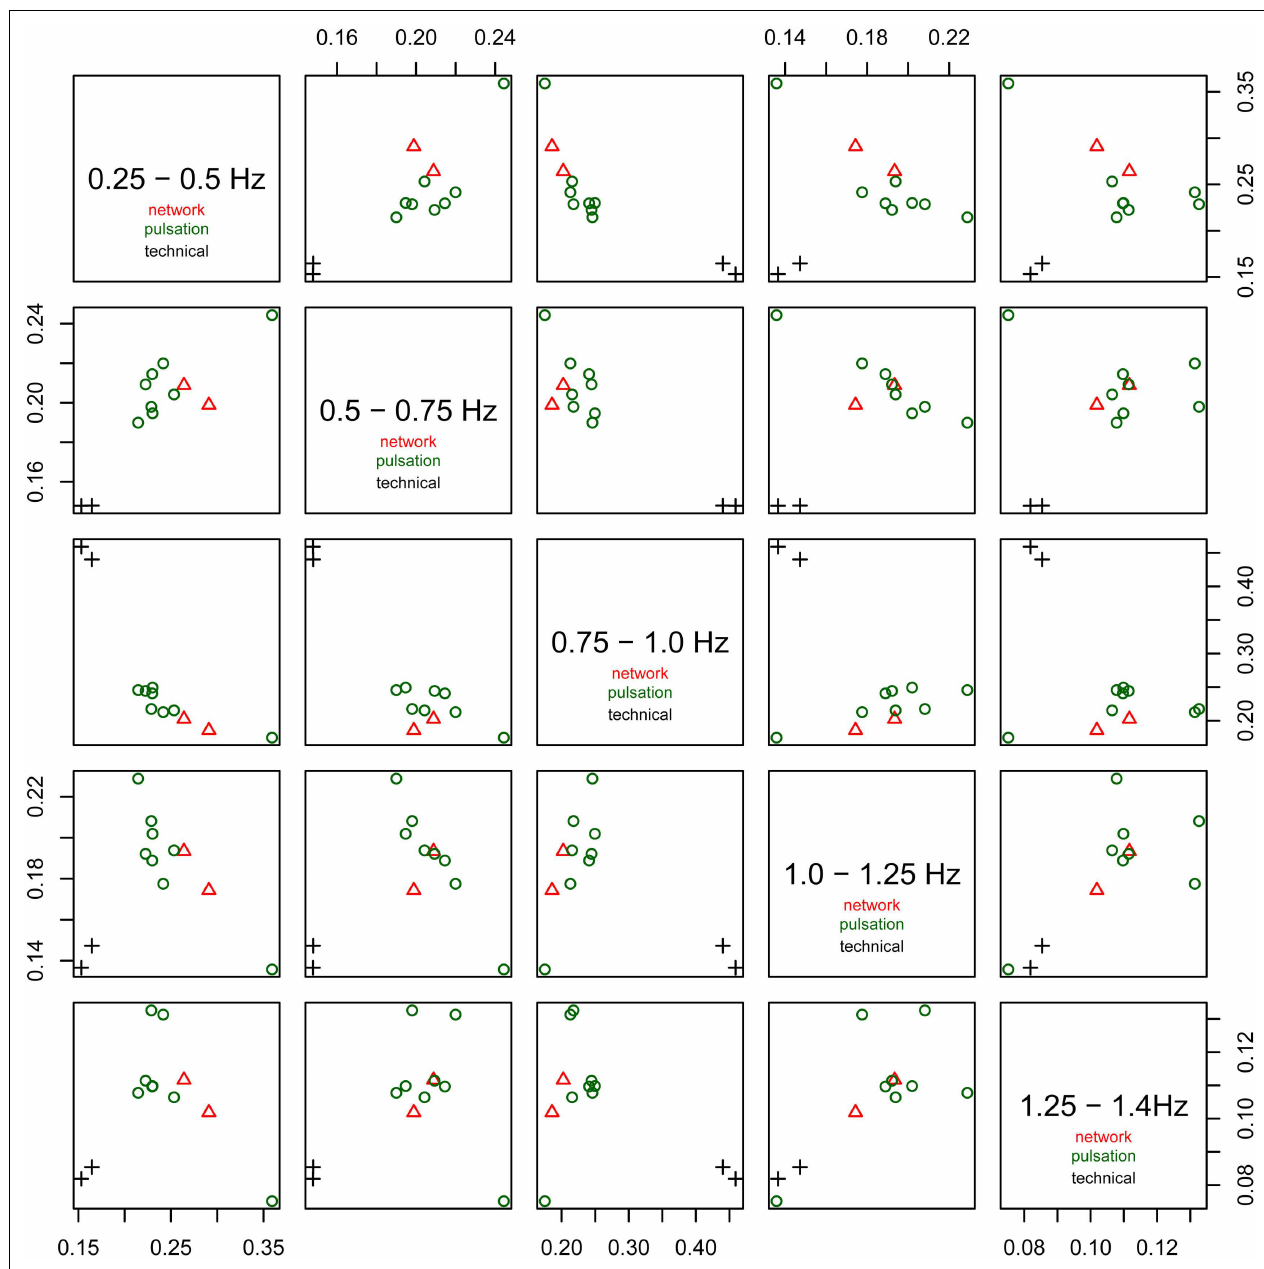
0.25–0.5, 0.5–0.75, and 0.75–1.0Hz. Components attributed to classical resting-state networks appear as mixed with pulsation components,